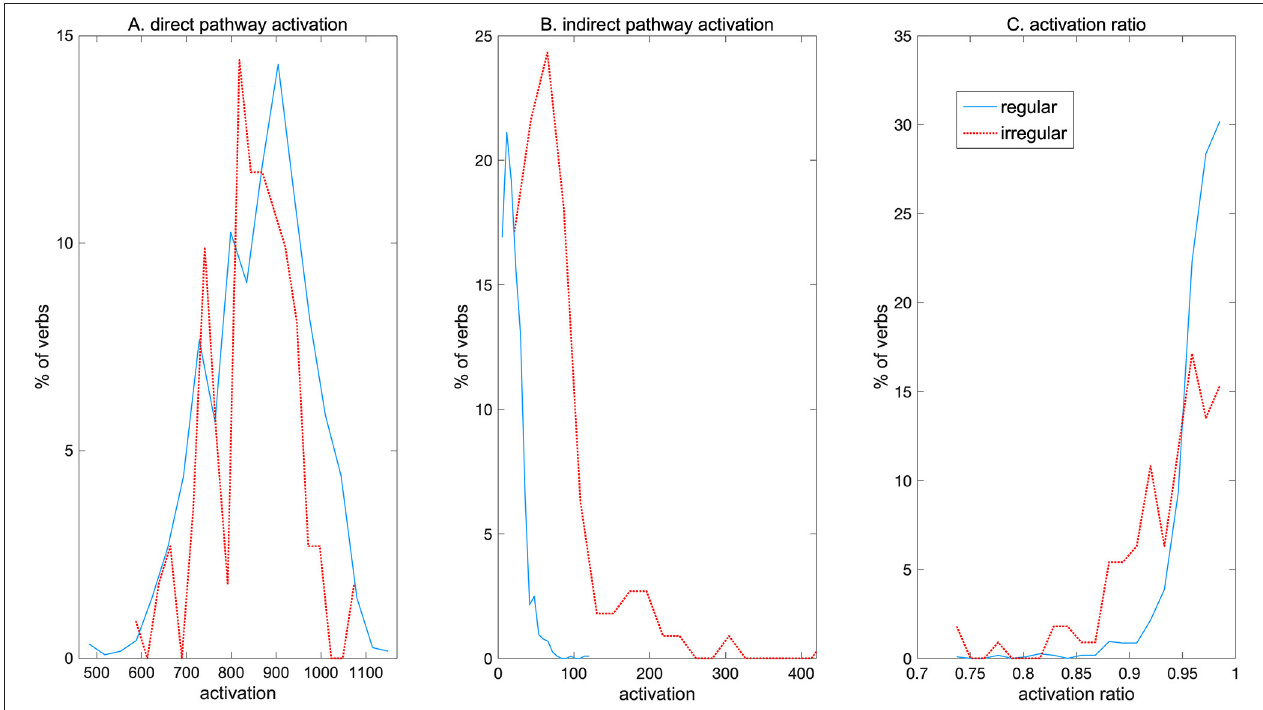
FIGURE 3 | Distribution of path activations by regular and irregular verbs. (A) Direct pathway activation. (B) Indirect pathway activation. (C) Activation